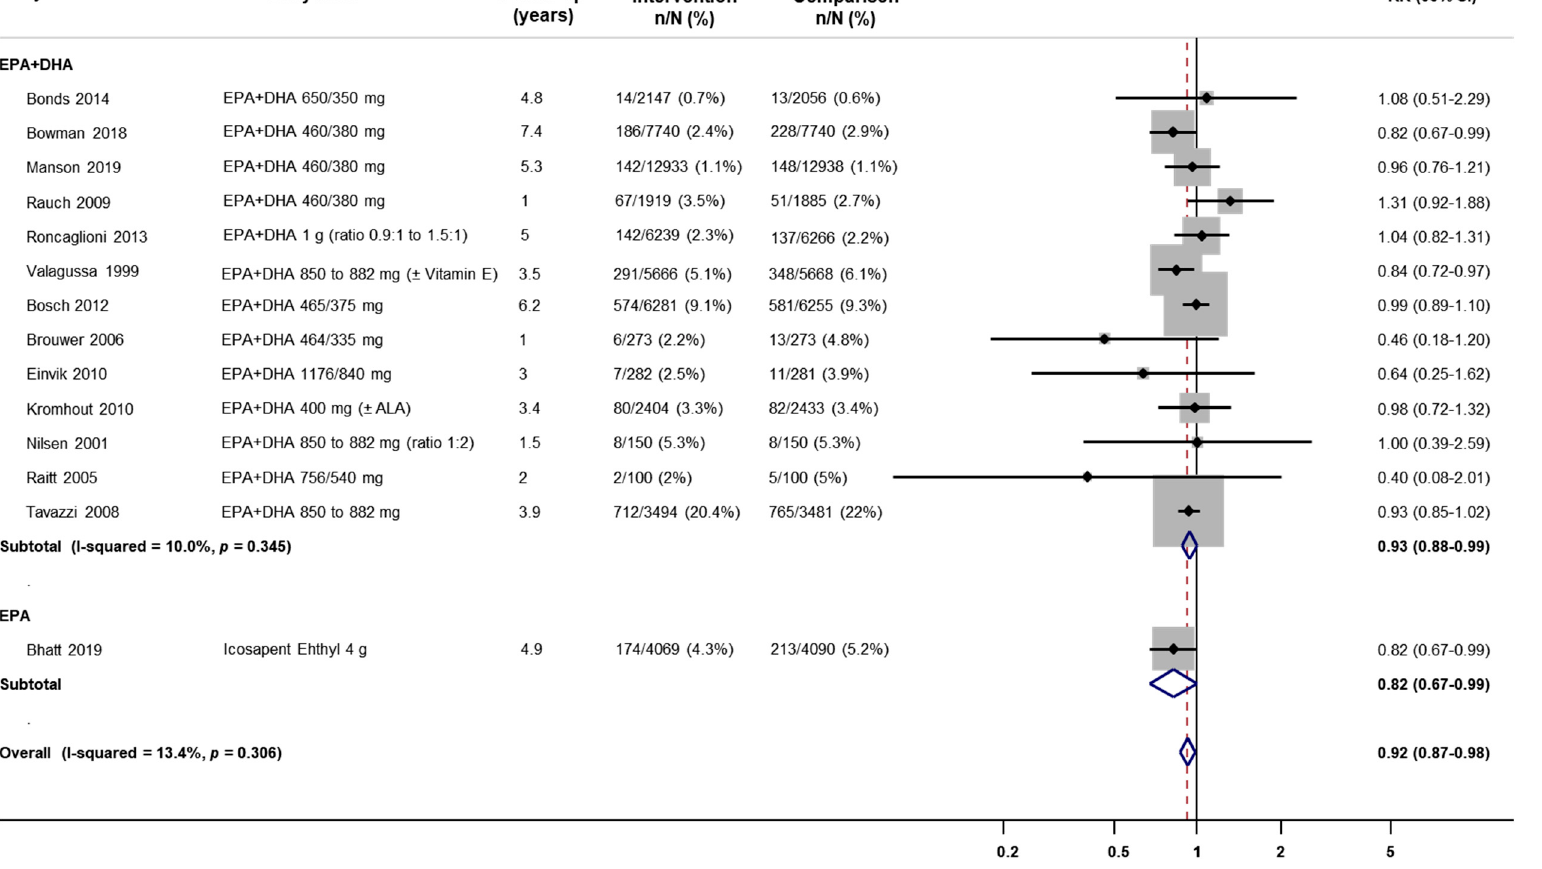
Figure A8. Subgroup meta-analysis for the e ff ect of di ff erent omega-3 supplementation types on cardiovascular disease death. Full black quadrilateral represents the point estimate of individual studies and blank with quadrilateral represents pooled estimates. RR, relative risk; CI, confidence interval; EPA, eicosapentaenoic acid; DHA, docosahexaenoic acid. ALA, alpha-linolenic acid. Pooled estimates for the overall study population and subgroups are highlighted with bold.